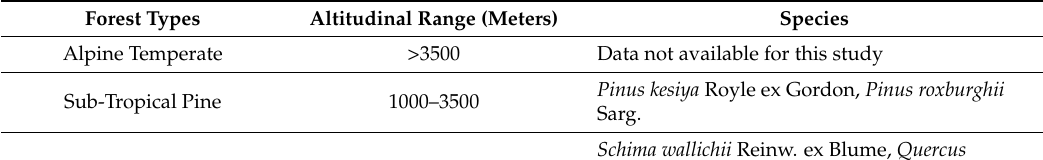
Table 1. Dominant and co-dominant tree species sampled for the present study.